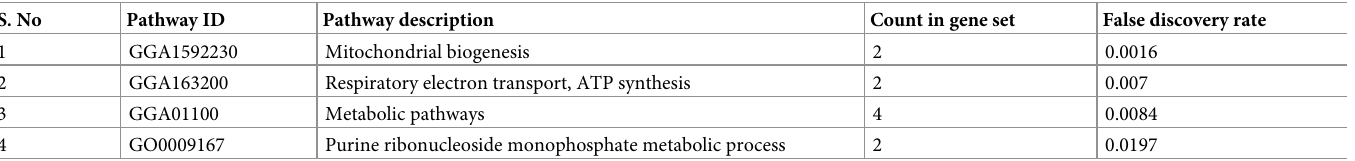
Table 4. Pathways upregulated by S . Enteritidis infected HTC cells. S.